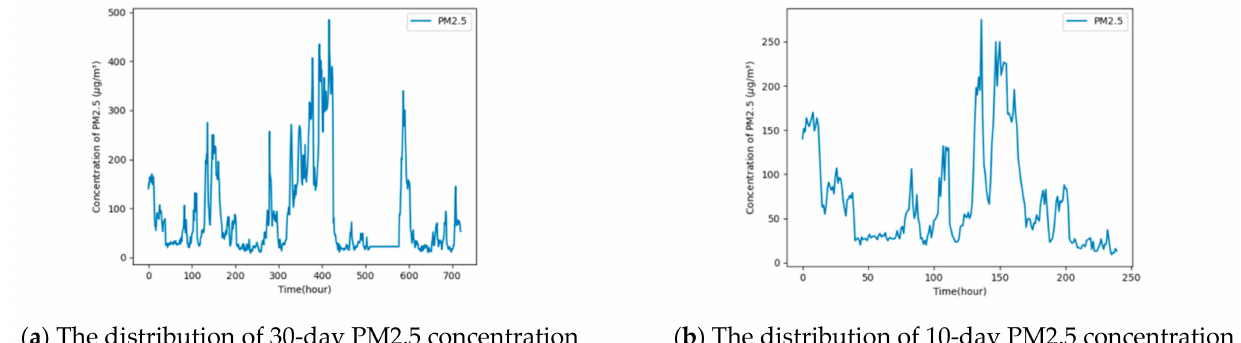
Figure 6. The trend of PM2.5